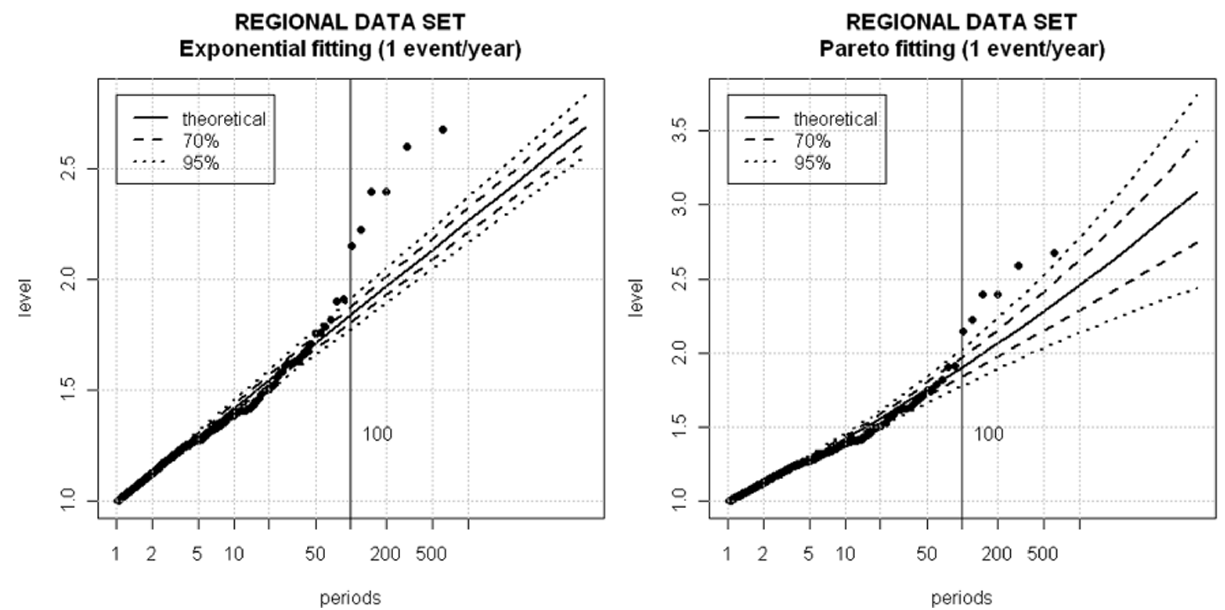
Fig. 8. Adjustments of the regional data set with the exponential and Pareto distributions. The 70% and 95% lines correspond to confidence intervals, the surge levels do not have units (normalized surges), and the return periods are in